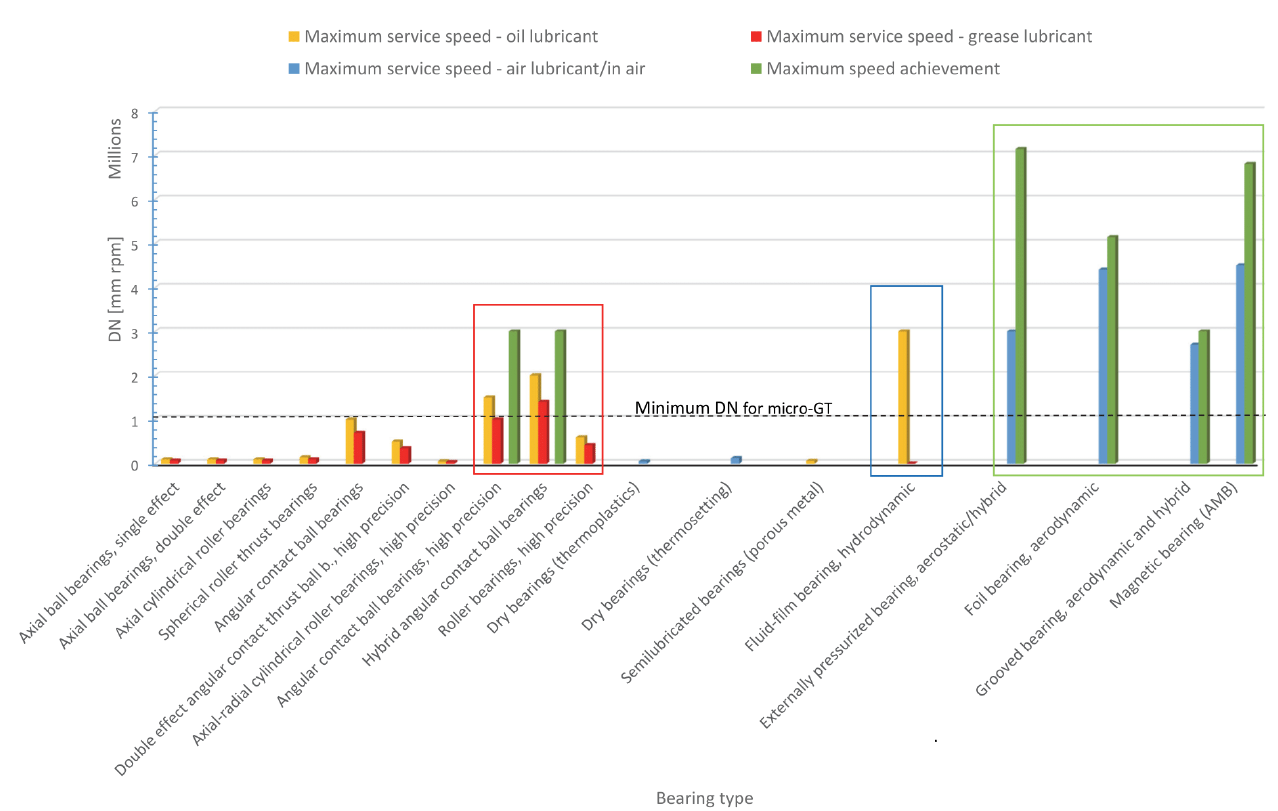
Figure 7. Admissible peripheral speed DN for candidate supports; dotted line shows the minimum allowable DN for micro-GT units